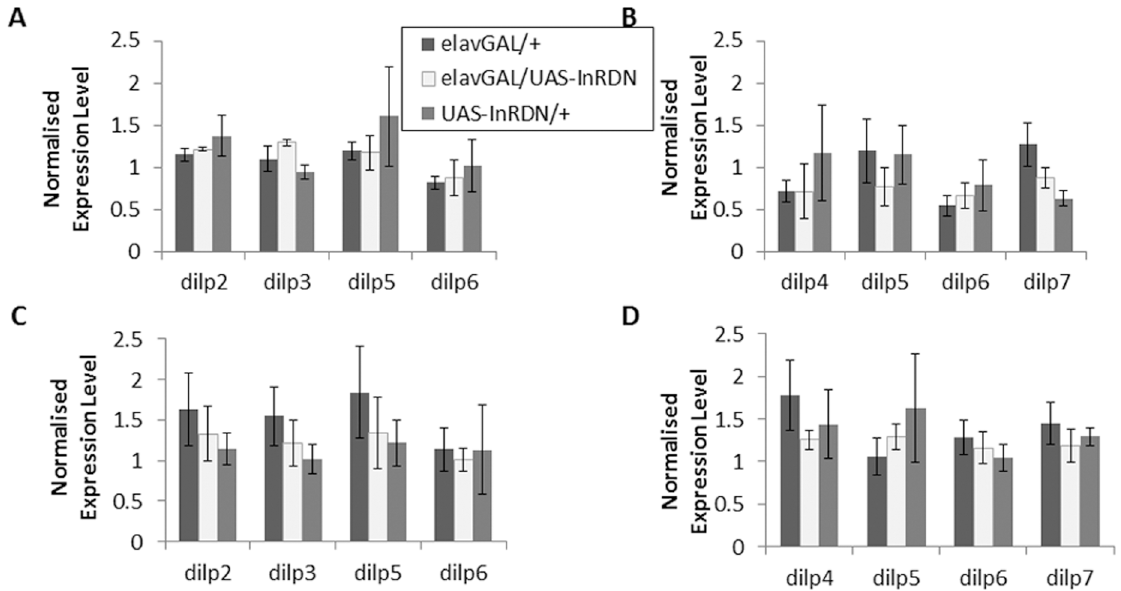
Fig 6. The Effect of InR DN Expression on dilp Expression. (A-D) The effect of UAS-InR DN expression in CNS neurons on dilp expression in 10 day old adult male and female heads and bodies was measured by quantitative RT-PCR, and N = 3 (groups of 20 heads or bodies) for each genotype. ( A ) dilp 2 , 3 , 5 and 6 relative transcript levels in elavGAL/UAS-InR DN and control female heads. ( B ) dilp 4 , 5 , 6 and 7 relative transcript levels in elavGAL/UAS-InR DN and control female bodies. ( C ) dilp 2 , 3 , 5 and 6 relative transcript levels in elavGAL/UAS-InR DN and control male heads. ( D ) dilp 4 , 5 , 6 and 7 relative transcript levels in elavGAL/UAS-InR DN and control male bodies. Data are shown as mean relative expression level ± SEM (N = 3).